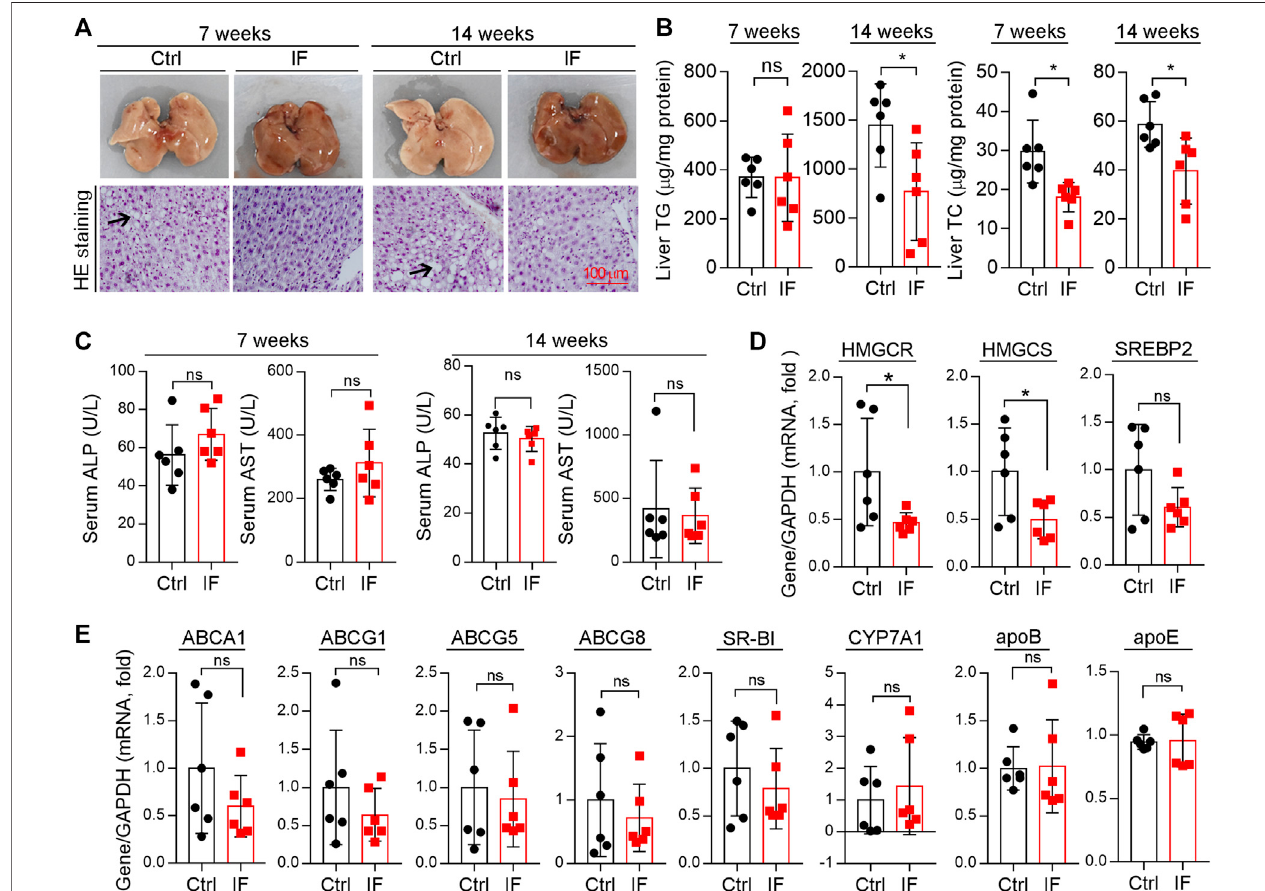
FIGURE 5 | Intermittent fasting reduces HFD-induced lipid accumulation in the liver by reducing cholesterol synthesis. (A) Liver photos and HE staining of liver paraf fi n sections. Arrows indicate the vacuoles of lipid droplets after HE staining. (B) Liver TG and TC contents were quantitatively determined and normalized to protein content. (C) : serum ALP and AST levels were determined using the enzymatic kits. (D,E) Expression of genes related to cholesterol synthesis [ (D) : HMGCR, HMGCS, andSREBP2],transport,andmetabolism[ (E) :ABCA1,ABCG1,ABCG5,ABCG8,SR-BI,CYP7A1,apoB,andapoE]weredeterminedbyqRT-PCR.* p < 0.05,ns: not signi fi cant ( n (cid:1)